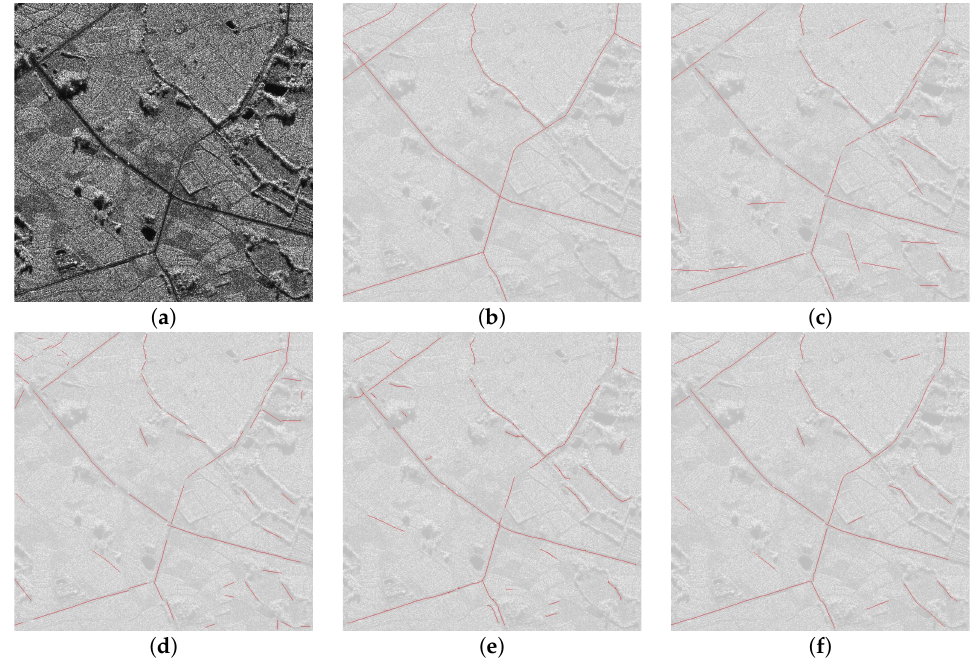
Figure 8. The experimental results on the second airborne SAR image from Hainan, China. ( a ) The span image; ( b ) ground truth; ( c ) roads of MLFD; ( d ) roads of beamlet; ( e ) results of MRF [8]; ( f ) fusion results of